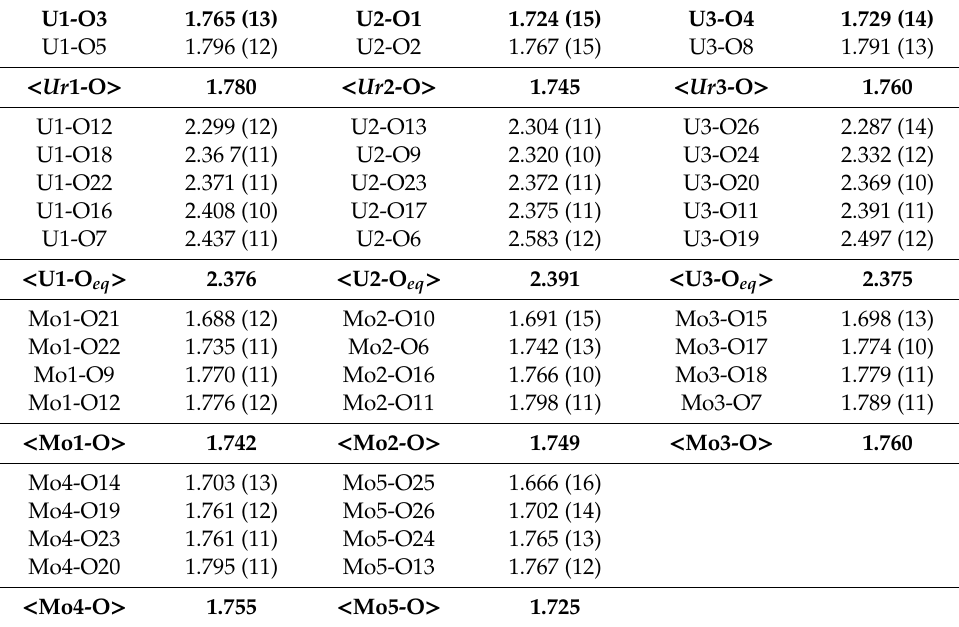
Table 2. Selected bond lengths Å in the structure of 1